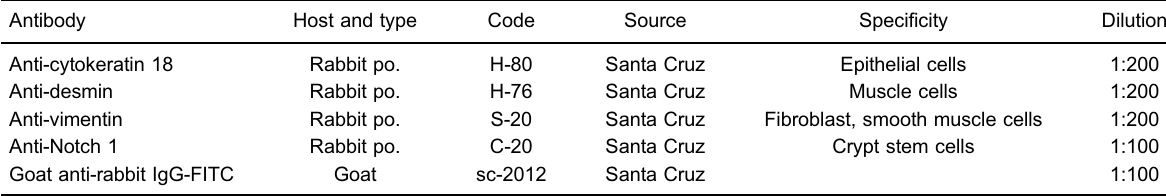
Goat anti-rabbit